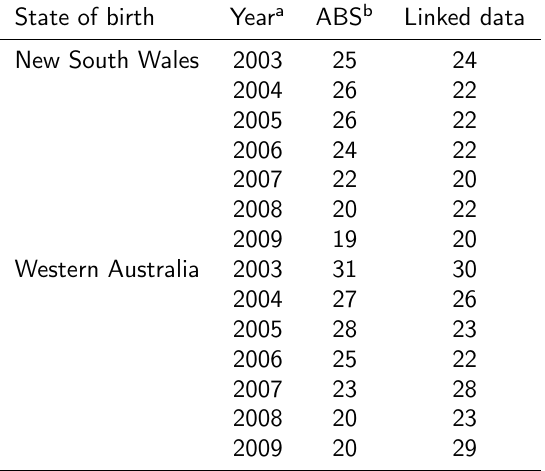
Table 1A: Mortality rates (per 100,000) for children 1-4 years of age by data source, state of birth and